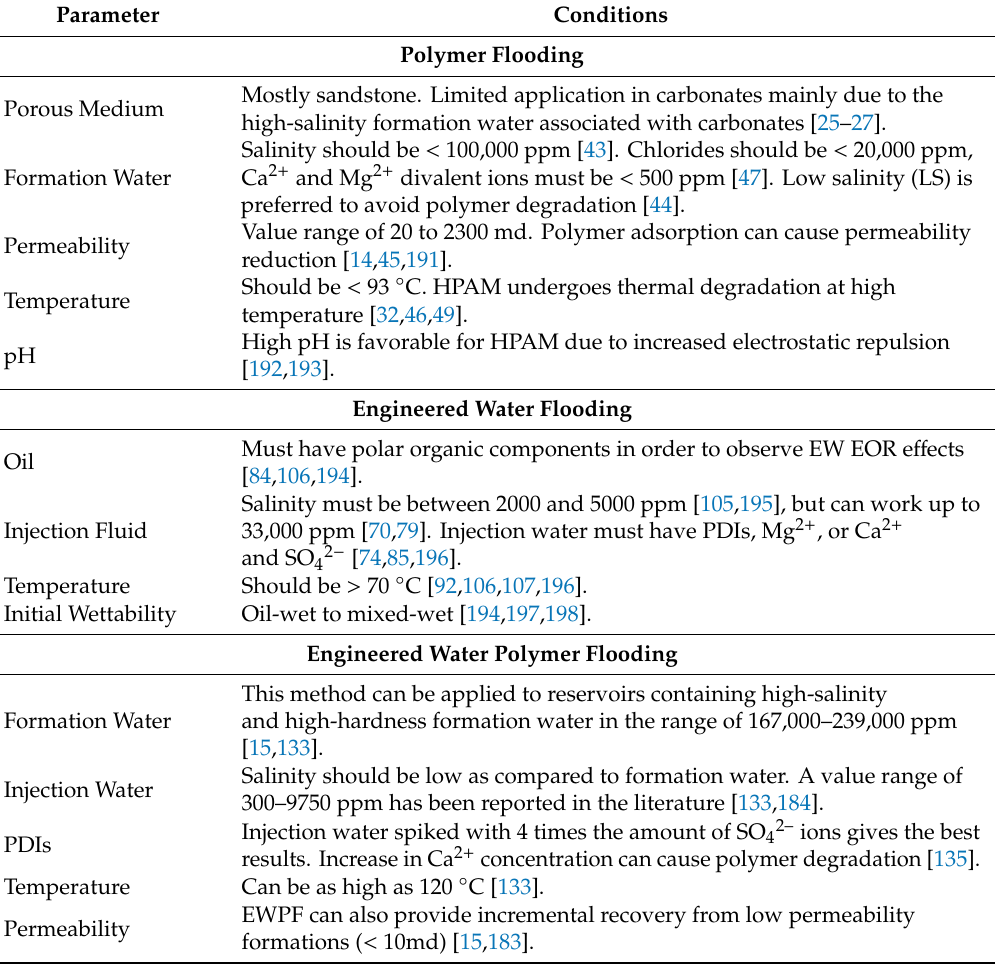
Table 2. Key conditions for polymer, engineered water, and engineered water–polymer flooding.